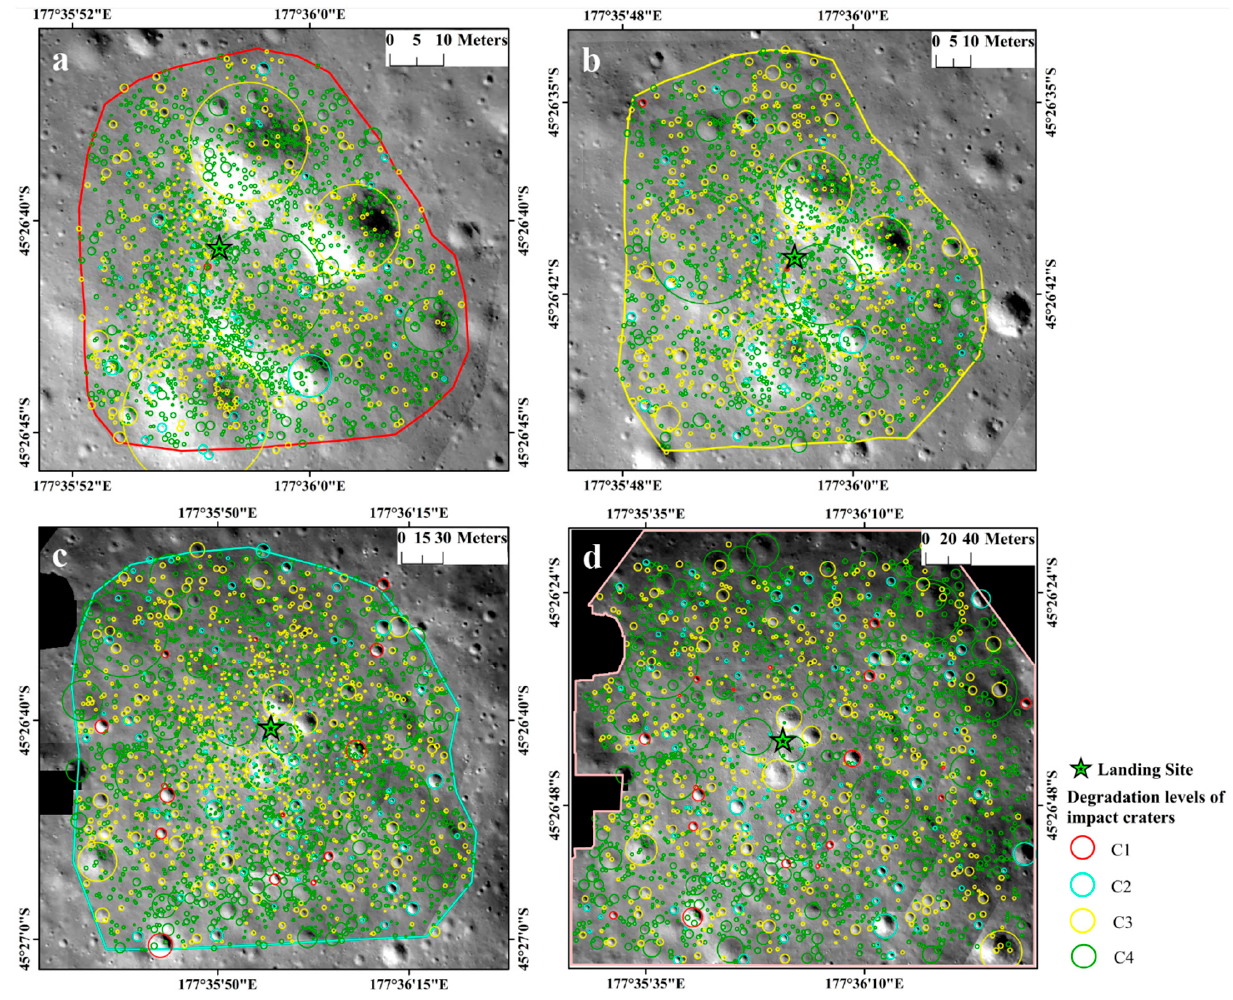
Figure 8. Crater distribution map with different degradation levels in different study areas. ( a – d ) show the red, yellow, aquamarine, and pink outlined study areas. Red, aquamarine, yellow, and green circles are C1, C2, C3, and C4 impact craters.